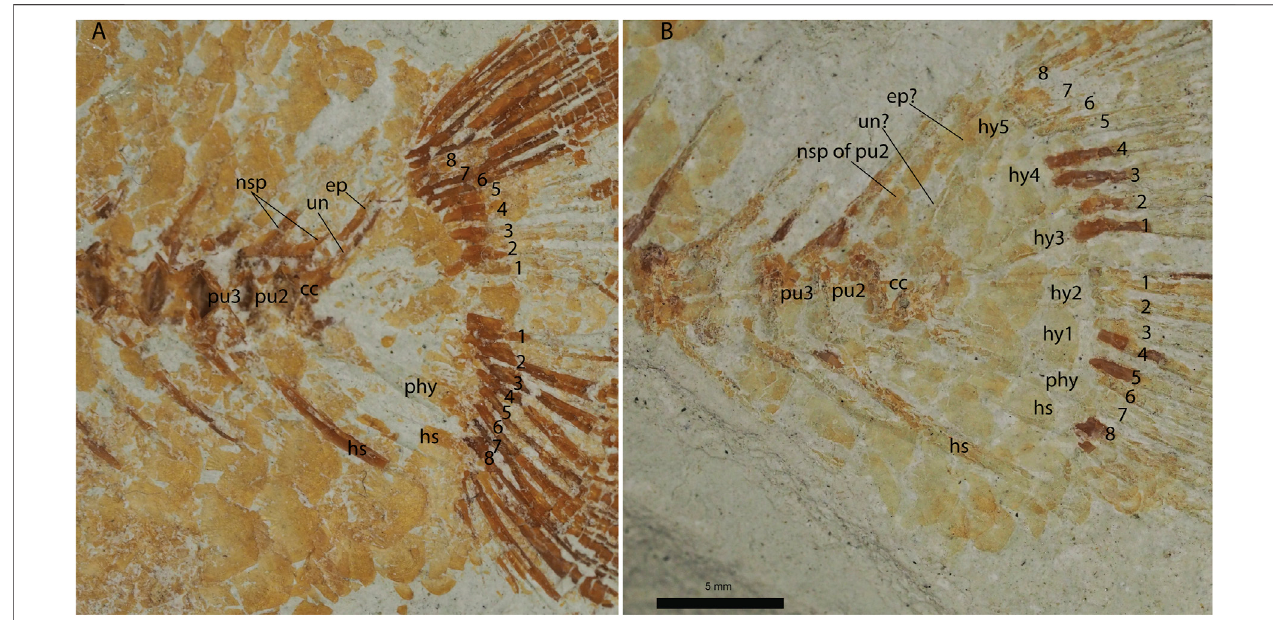
FIGURE 4 | Photograph and interpretation of the caudal fi n of Somalichromis hadrocephalus gen. et sp. nov. (A) , holotype NHMUK P.29574; (B) , paratype NHMUK P.29576.